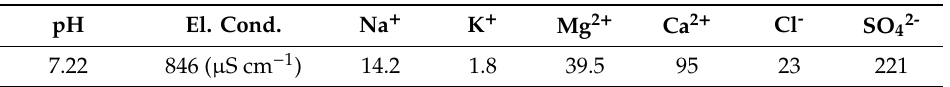
Table 1. Major parameters and components of the mineral water feed solution; El.Cond.: Electrical Conductivity, all ions in (mg L − 1